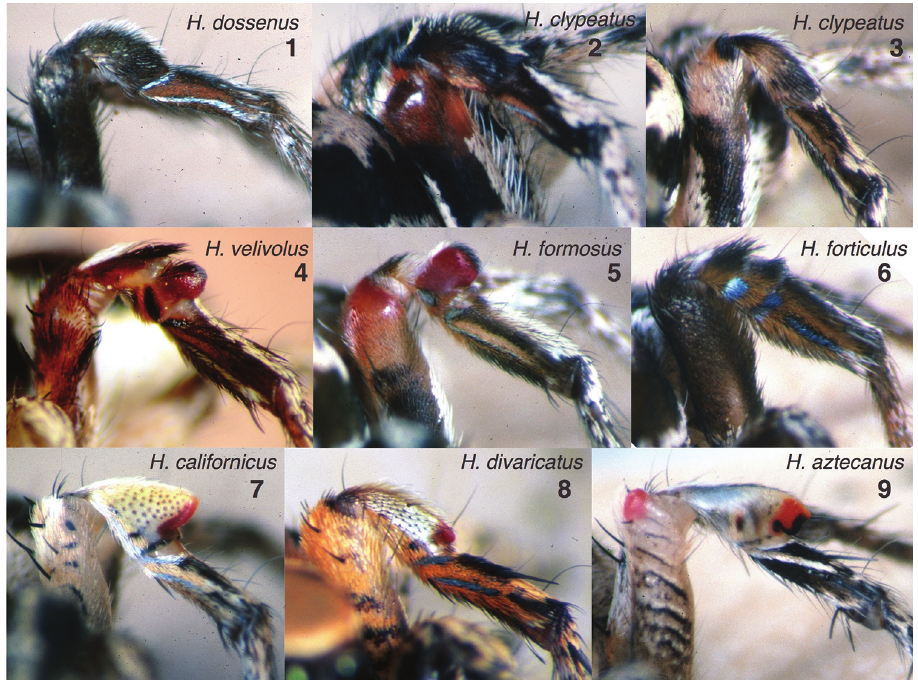
Figures 1–9. Third legs of males of described species in the Habronattus clypeatus species group. Left legs shown, except Figs 1, 2, 7, 9 which show digitally-flipped images of right legs. 1 H. dossenus Griswold, 1987, from U.S.A.: Arizona: Cochise Co.: Lower Turkey Creek, Chiricahua Mts, 109.42°W, 31.85°N, 2 H. clypeatus (Banks, 1895) (montane form), from U.S.A.: Arizona: Jack’s Canyon near Flagstaff 3 H.